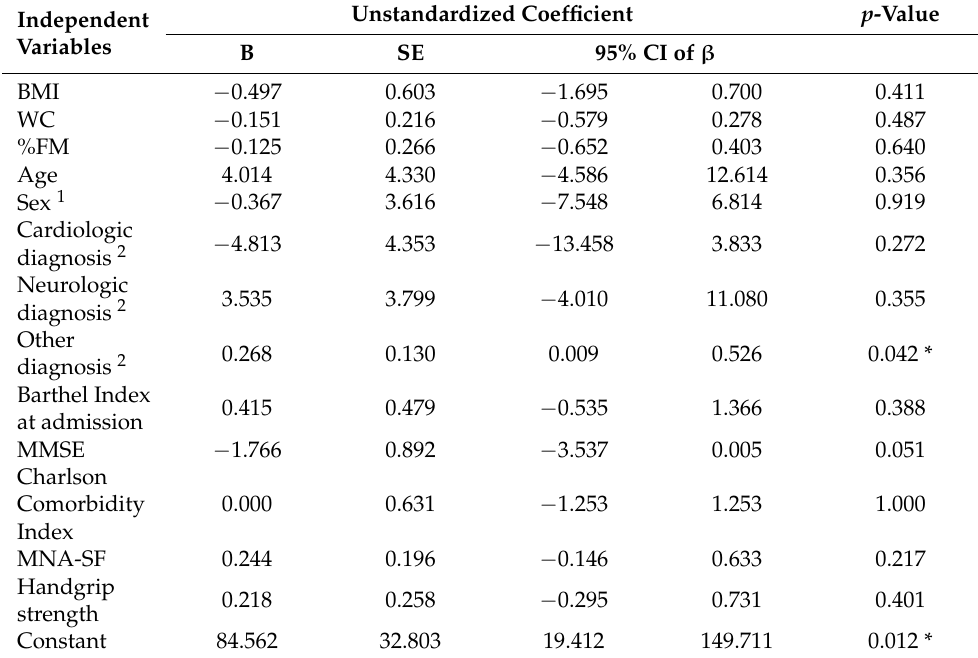
Table 3. Multiple regression analyses considering Barthel index at t3 as dependent variable ( n = 109).